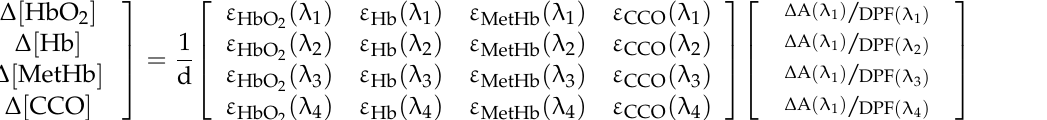
Figure 8. Molar extinction coefficient of five different blood chromophores in function of the light wavelength based on the literature [21] (OD: Optical Density; M: mol/L; cm: centimeter). According to the Modified Beer–Lambert Law (MBLL) [23], the UCL4 algorithm [18,24] was applied to calculate the concentration evolution of these elements through this matrix